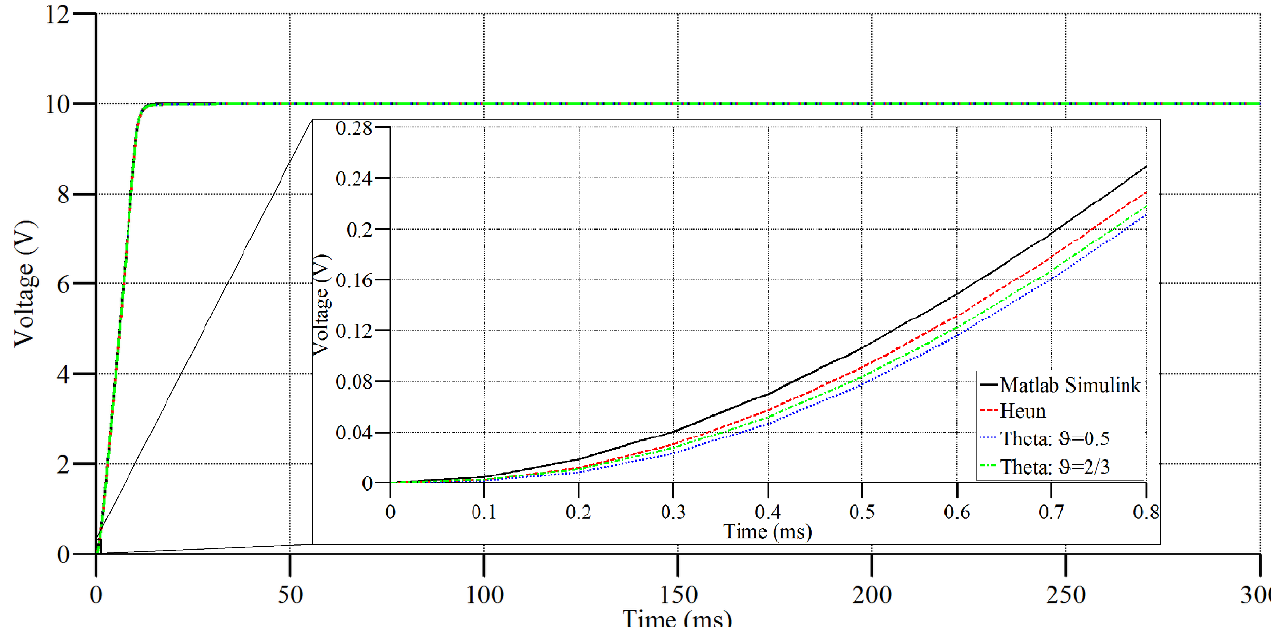
Figure 5. Capacitor voltage during the 0–0.8 ms time interval.